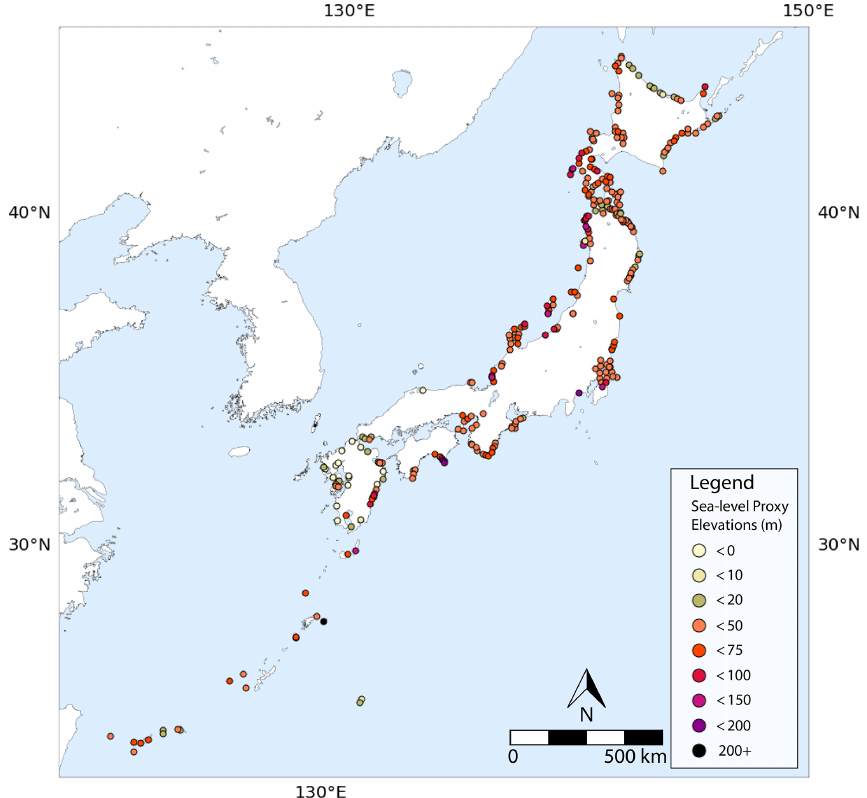
Figure 12. Sea-level elevation proxies over the Japanese archipelago. Sea-level indicators (circles) and elevation range indicated by color (see